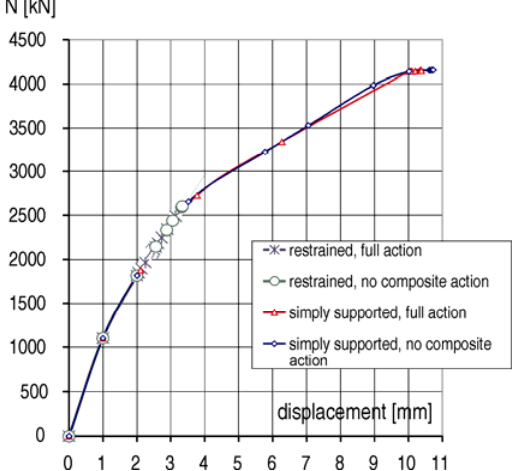
Fig 15 . Load displacement characteristic of the composite column for the different conditions of boundary and inter- action between steel and